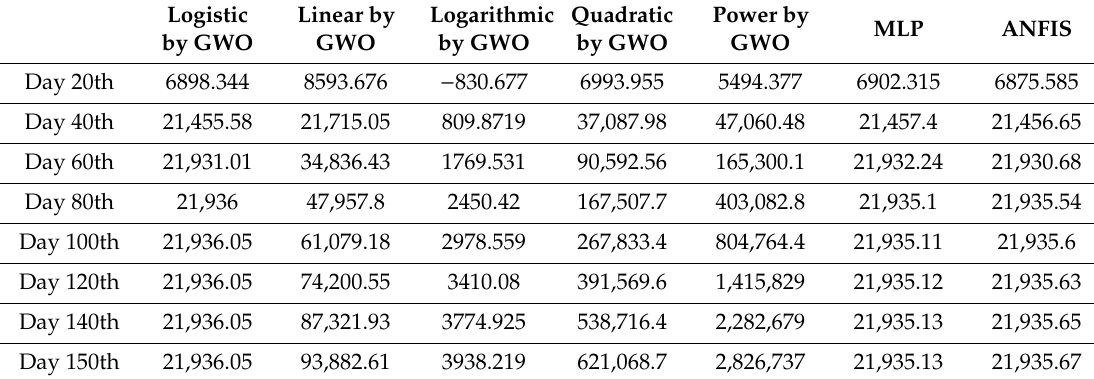
Table 19. The outbreak prediction for Iran through 150